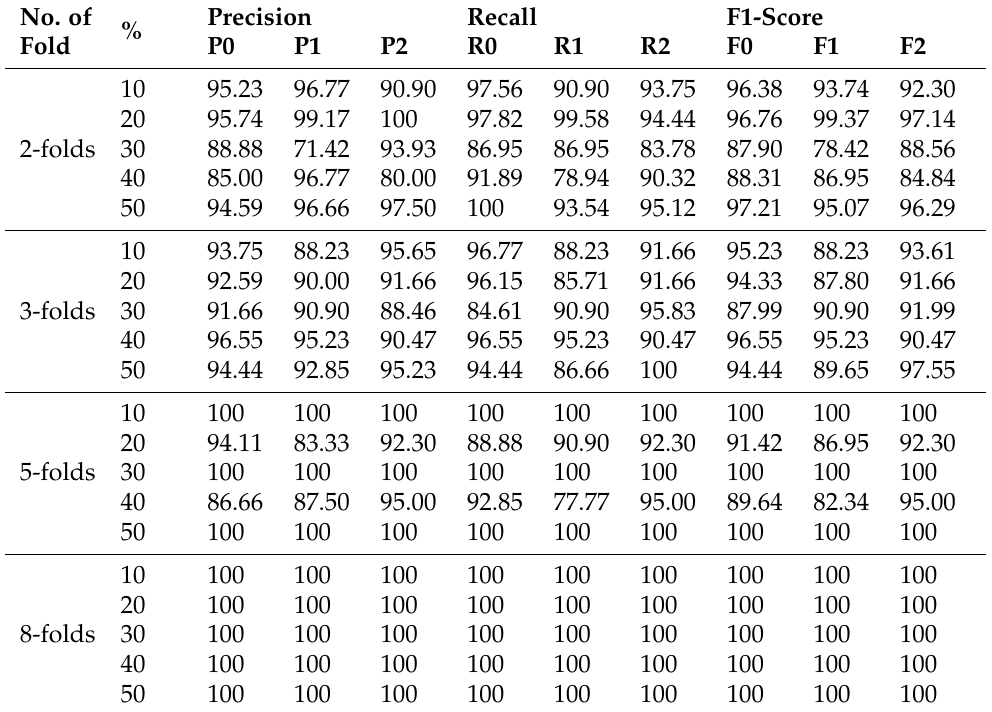
Table 4. Redundant frame without segmentation.